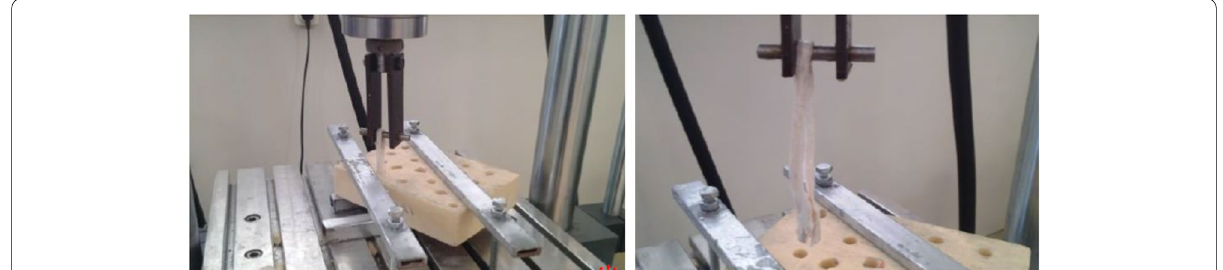
Fig. 8 Mechanical testing of a sample mounted into a tensile testing